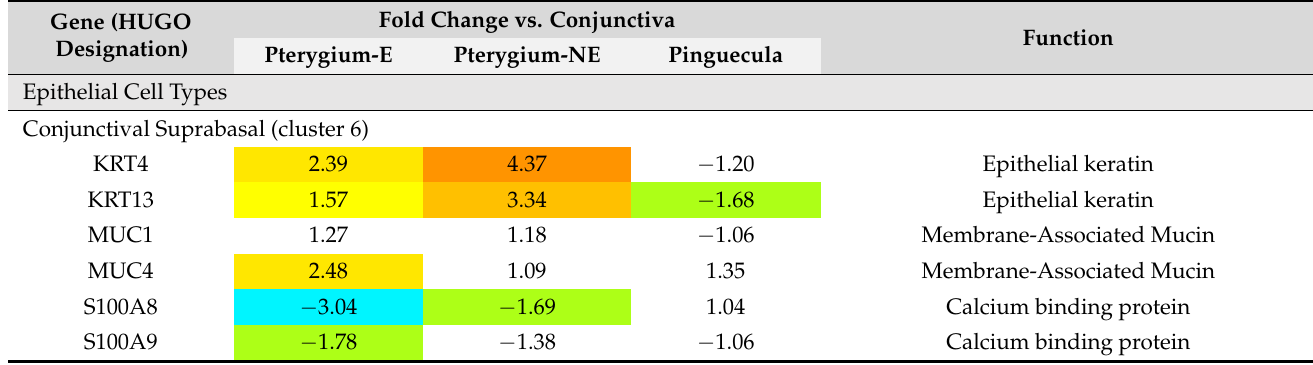
Table 6. Changes in Expression of Cell Type Signature Genes in Human. Fold Change vs. ConjunctivaGene